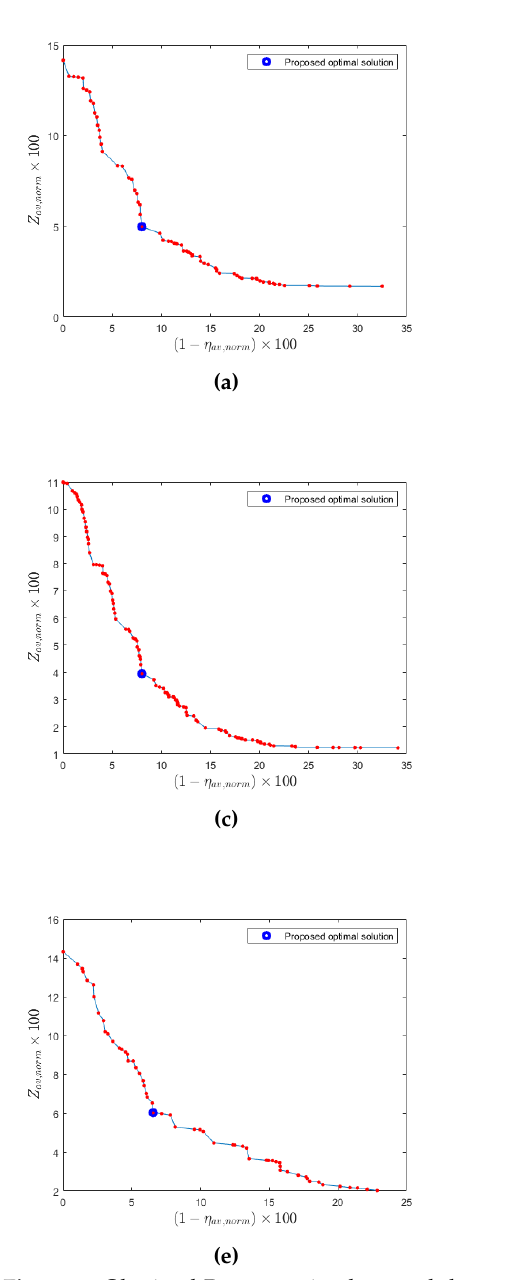
Figure 3. Obtained Pareto-optimal set and the proposed optimal solutions. ( a – c ) The solutions for r a −→ b and q = 4, q = 5, q = 6, respectively. ( d , e ) Solutions for r b −→ a and q = 4, q = 5,